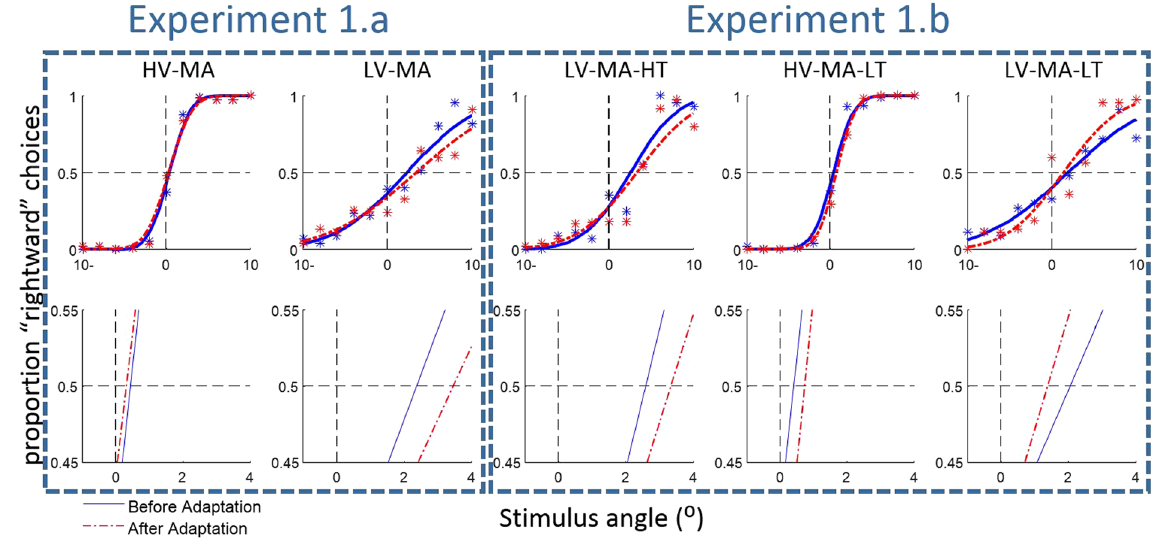
Figure 2. Fitted psychometric functions to all trials of all participants. The first row shows the psychometric functions before and after adaptation in all reliability conditions. The second row shows the magnified plots of the first row around the